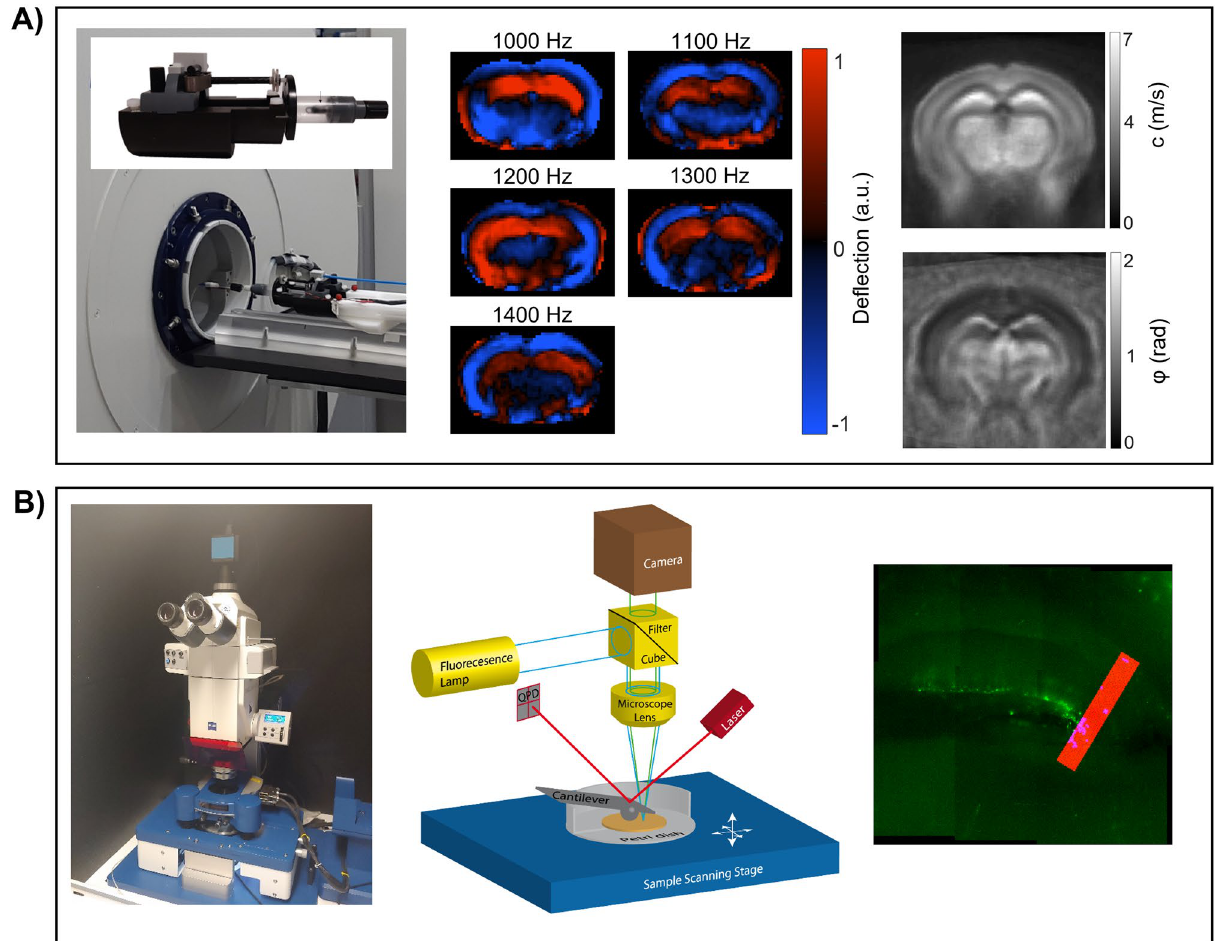
Figure 1. MRE and AFM setup. ( A ) On the left, the 7-Tesla animal scanner is shown along with customized animal holder, comprising a nonmagnetic piezoceramic actuator for wave generation, transducer rot (for wave transmission into the animal`s skull), and an anesthesia mask. In the middle, wave images showing shear wave propagation in the mouse brain at the 5 vibration frequencies (after k-MDEV inversion, 1 slice, 1 component, and no directional filters applied). On the right, a representative averaged MRE c-map and φ-map are shown. ( B ) On the left, the atomic force microscopy setup, in the middle a schematic drawing of the AFM, illustrating the main components of an AFM, and on the right, a representative image of a brain slice with a measurement profile are via a transducer rod as shown in Fig. 1A. A total of 7 coronal slices (in the Bregma areas − 2.84 mm (mm) to 0.23 mm) with 0.8 mm slice thickness were acquired using a single-shot echo-planar imaging sequence as described in detail in 17 . Further imaging parameters were: 0.18 mm × 0.18 mm in-plane resolution, echo time (TE) = 53 ms (ms), repetition time (TR) = 4000 ms, 16.2 × 10.8 mm 2 field of view (FOV), total scan time (TA) of 9 min (min). Tomoelastography postprocessing 34 was performed to derive shear wave speed (c in m/s) as a surrogate marker of stiffness, based on multifrequency wave-number analysis. To recover the phase angle of the complex shear modulus (φ in rad, also termed loss angle), Laplace-based direct multifrequency inversion was used 20 . To match AFM measurement, parameters c and φ (Fig. 1A right) were analyzed in bregma area − 2.4945 mm to − 2.0745 mm. Furthermore, c and φ were converted to shear stiffness (magnitude of the complex shear modulus |G*| in Pa) by